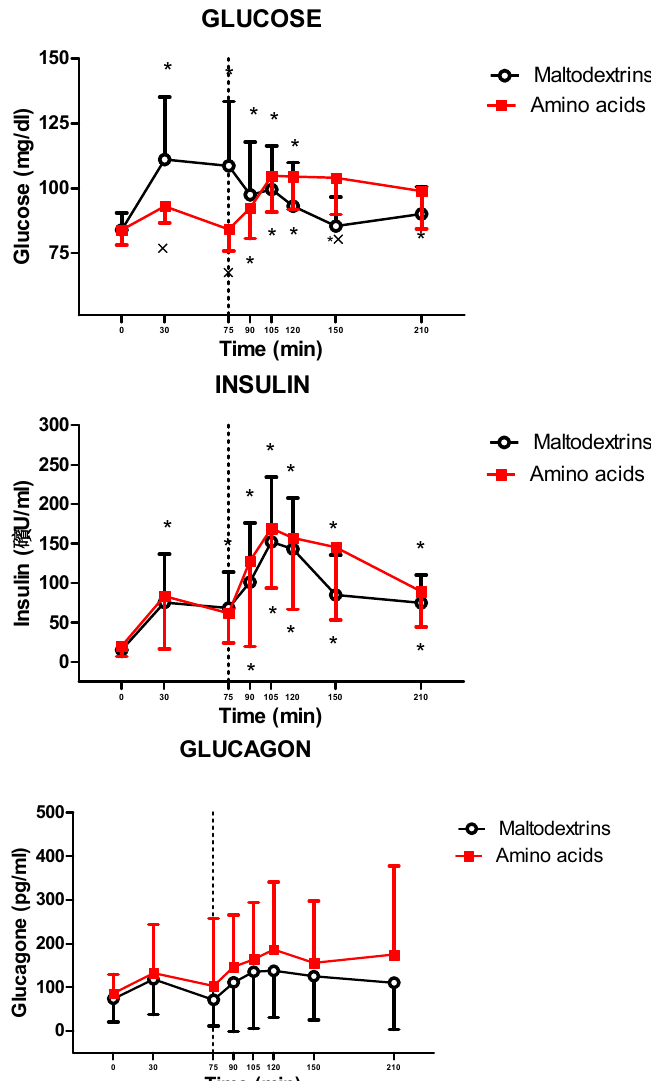
Figure 4. Changes of circulating levels of glucose (top panel), insulin (middle panel), and glucagon (bottom panel) in obese adolescents after a fixed-dose lunch (completely consumed within 15 min starting at T75) administered with amino acid mix (L-arginine, L-leucine, L-glutamine, and L-tryptophan) or placebo (maltodextrins) at T0. See the text for further details. Values are expressed as means ± SDs. The number of subjects was 14. * p < 0.05 vs. the corresponding T0 value; × p < 0.05 vs. the value in the maltodextrin-treated group at the corresponding time point. A two-way ANOVA with repeated measures (with the two factors time and group and the interaction time × group) followed by the post hoc Tukey’s test was used.